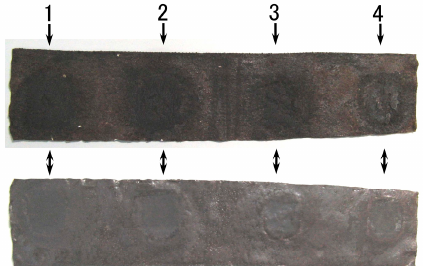
Figure 17. Photographs of obverse and reverse surfaces of wet-type MCF rubber solar cell electrolytically polymerized under a magnetic field. The upper photograph is the cathode side at electrolytic polymerization (UC), and the lower surface is the anode side (LA). A transparent glass (20 mm × 30 mm) and a second one coated with TiO 2 were placed in contact with UC and LA respectively, as shown in Figure 17. KI + I 2 was deposited On UC 7.4-g, and ruthenium